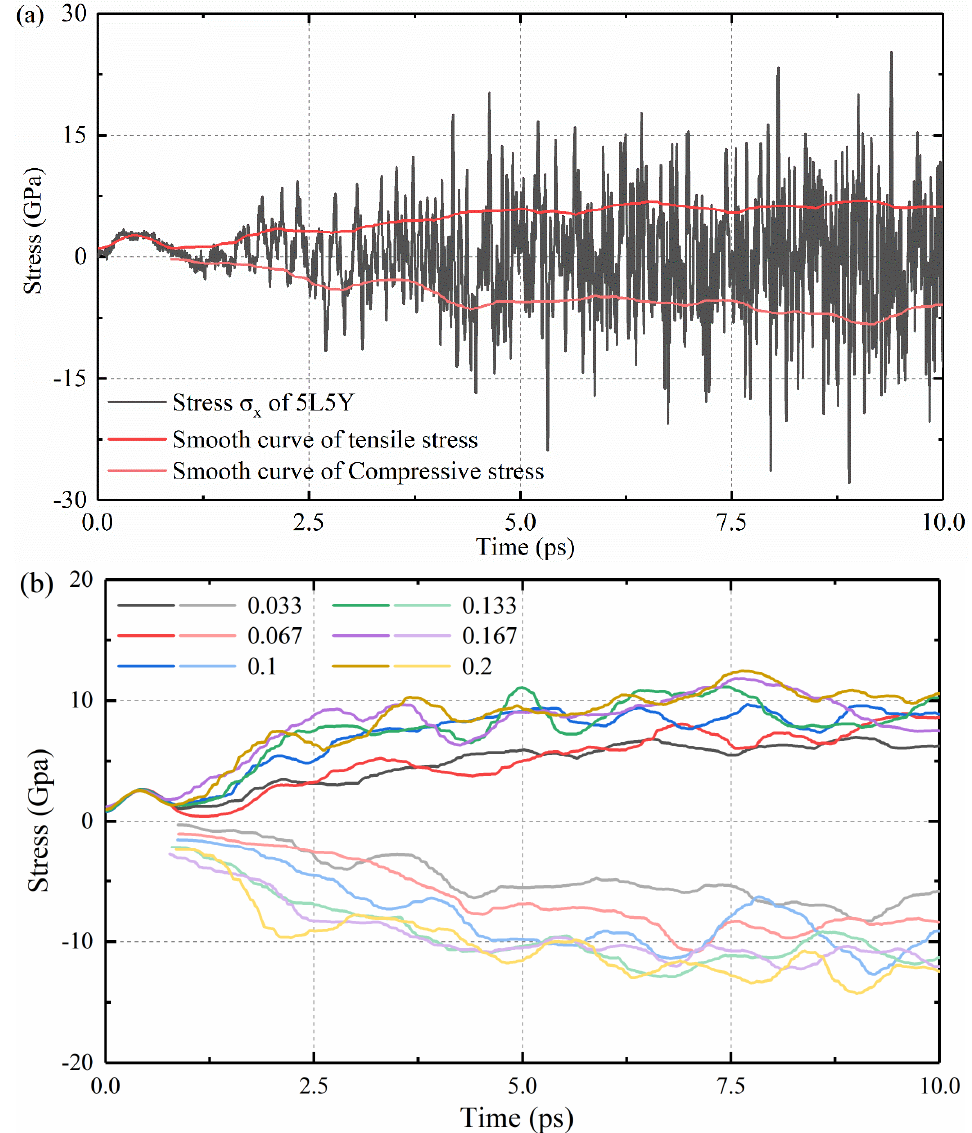
Figure 3. ( a ) The stress component σ x generated by group 5L5Y was displayed before and after smoothing; ( b ) The stress component σ x generated by group 5L5Y at different concentrations was compared after smoothing.